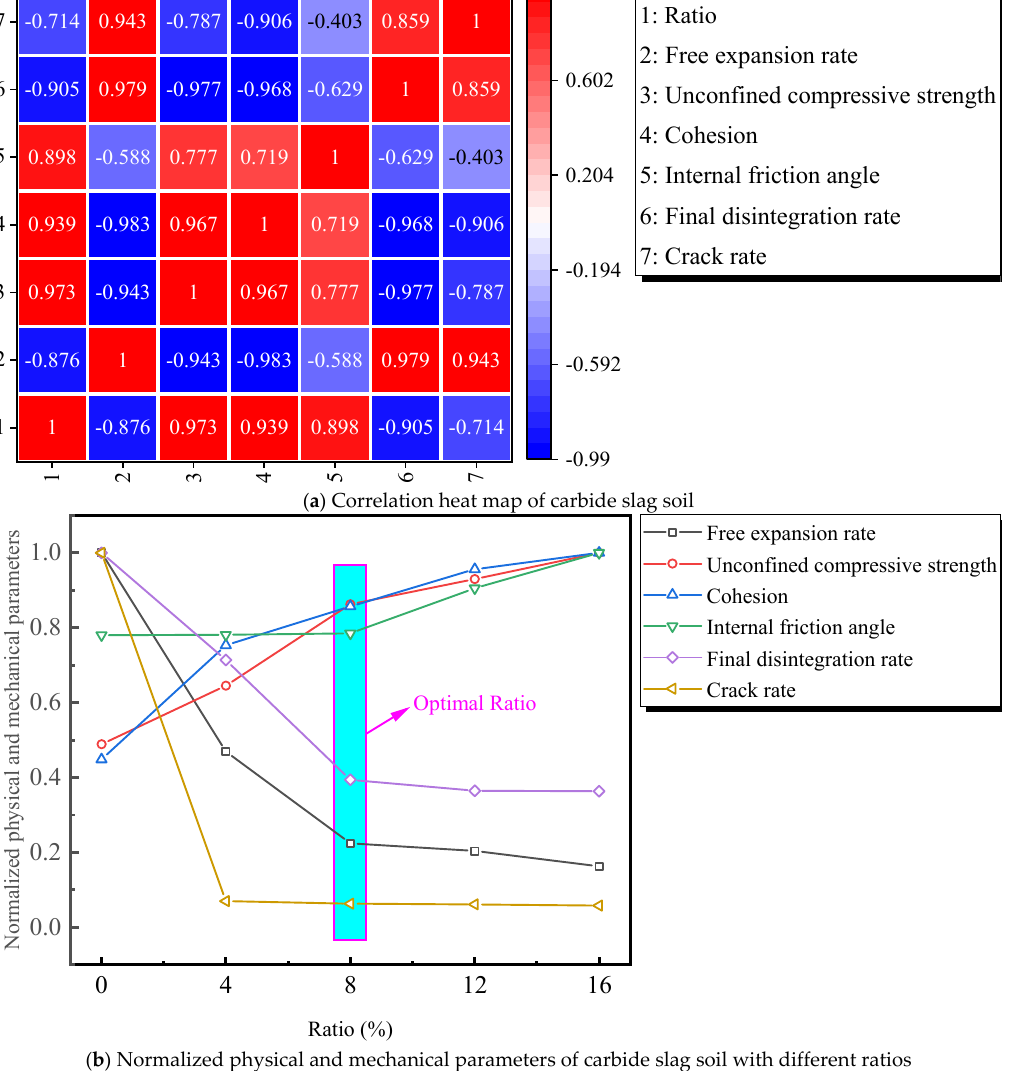
Figure 13. Response characteristics of physical and mechanical parameters of carbide slag soil.